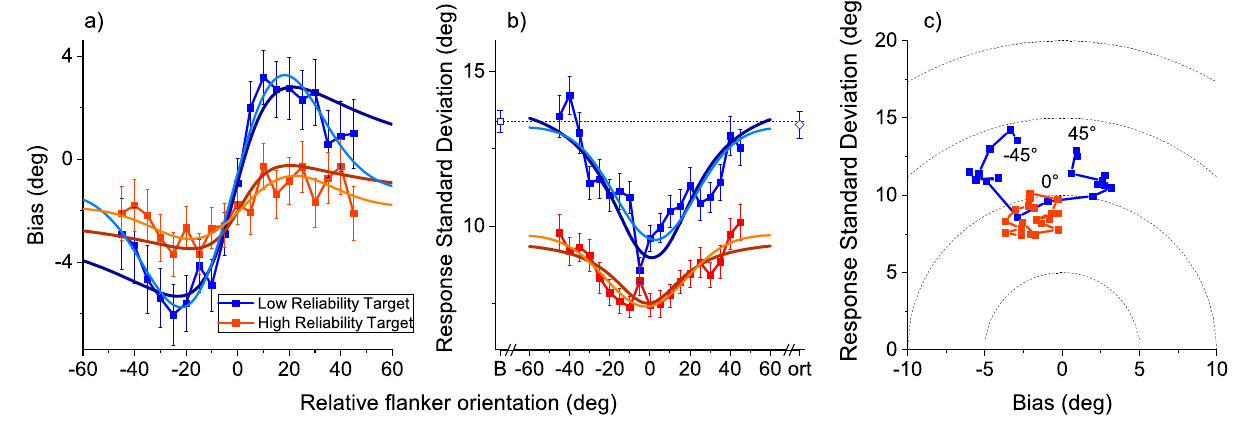
Fig. 2 | Crowding depends on stimulus reliability and follows optimality rules. a Average response bias (response minus target orientation) as a function of the orientation of two identical fl ankers. Low reliability (rounded) targets in blue, high reliability(elongated)inred.Positivebiasesrefertoclockwiseresponseerrors,and positive orientationdifferences indicate that fl ankersare clockwise withrespectto thetarget(sothebiasesareassimilative).Errorbarsshow±1SEM. N =10observers. Dark lines show predictions from an ideal-observer Bayesian model which scales theactionof fl ankersaccordingtotheirreliabilityandorientationdifference(Eq.10 of model section). Light blue and red curves show predictions for the causal inference model that doses fl anker and target information according to their